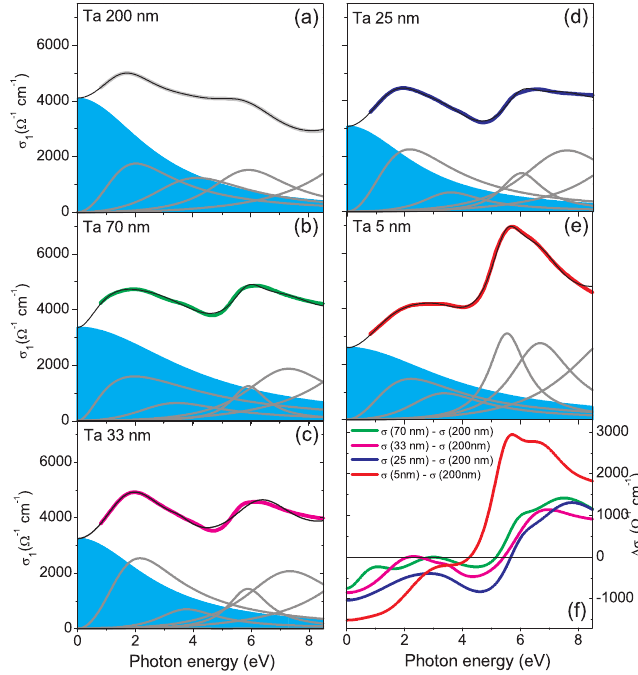
Figure 4. ( a – e ) Optical conductivity, σ 1 ( ω ) = 1 ωε 2 ( ω ) , of the studied Ta films of different thickness 4 π (shown by color curves). The contributions from the Drude term (cyan shaded area) and Lorentz oscillators (solid gray lines) are explicitly displayed. Solid black lines show their summary contribution to the optical conductivity; ( f ) Difference for the optical conductivity spectra of the single layer Ta films with decreasing film